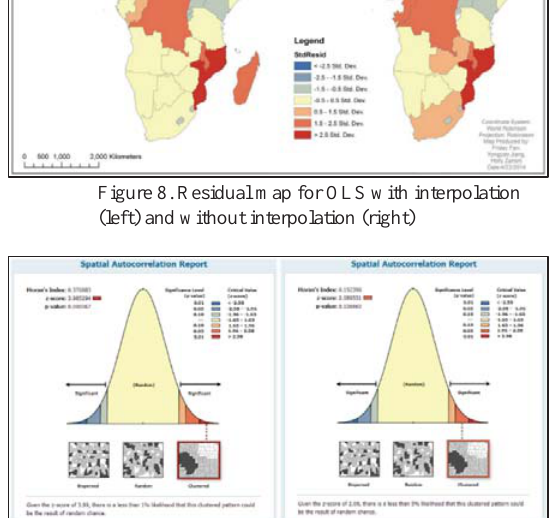
Figure 9. Spatial autocorrelation report for OLS with Interpolation (left) and without interpolation